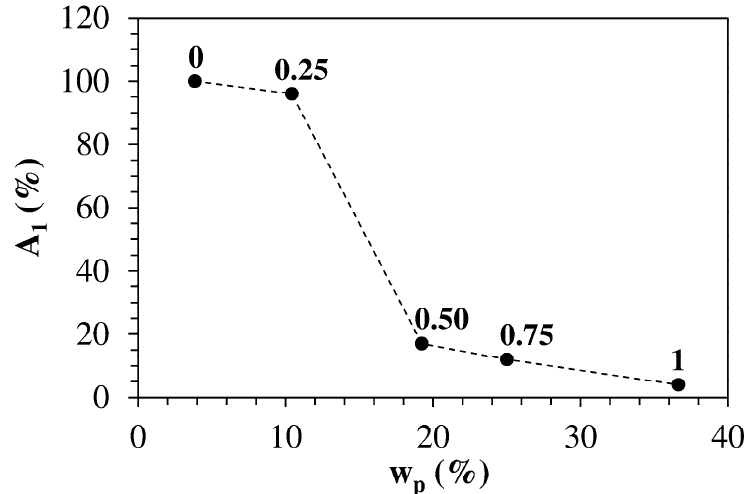
Figure 7. Variation of the fraction of the smaller crosslink density zones (A 1 (%)) with the polymer mass fraction w p , which is proportional to the reported values of f ODA . Each datum represents the average of 36 replicates.